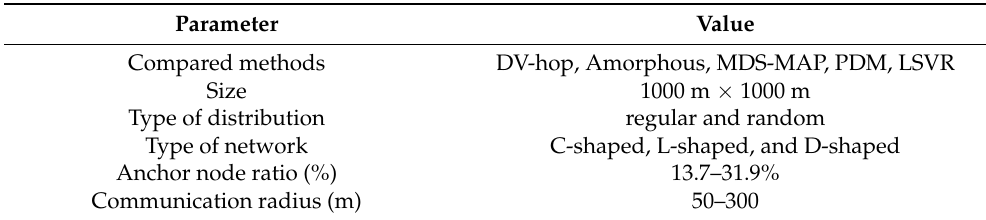
Table 2. The simulation parameters.